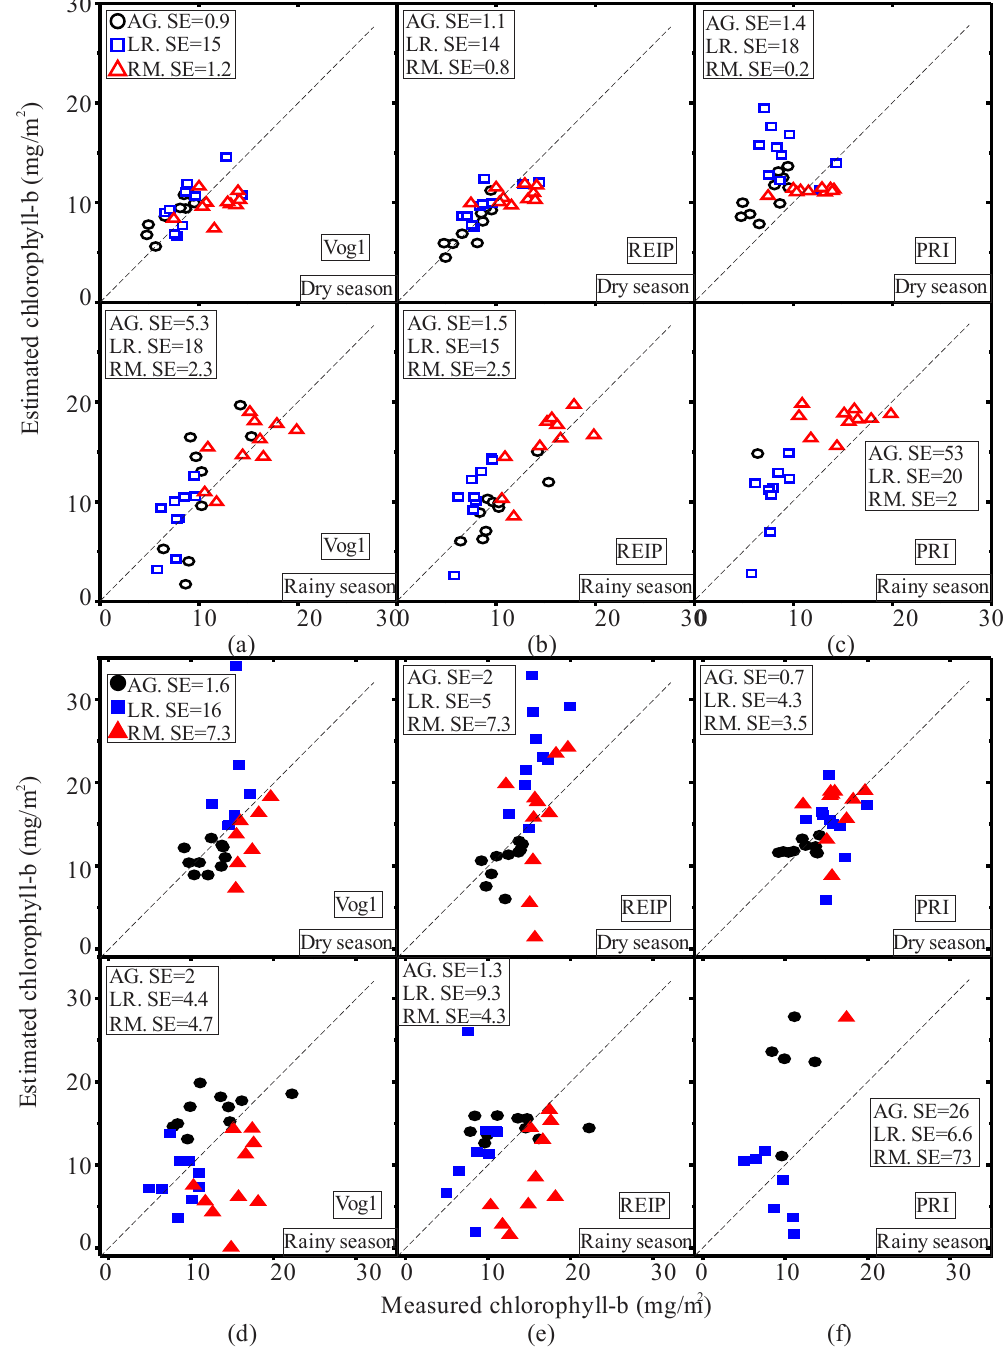
Figure 8. Predicted versus measured chlorophyll-b content during the dry and rainy seasons based on select regression equations from Tables 3 and 4. Hollow symbols indicate stressed mangroves while filled symbols indicate healthy mangroves. The standard error of estimate (SE) is indicated for each prediction. The dashed lines represent a 1:1 relation. ( a ) Stressed condition Vog1; ( b ) REIP; and ( c ) PRI; ( d ) healthy condition Vog1; ( e ) REIP; and ( f ) PRI.